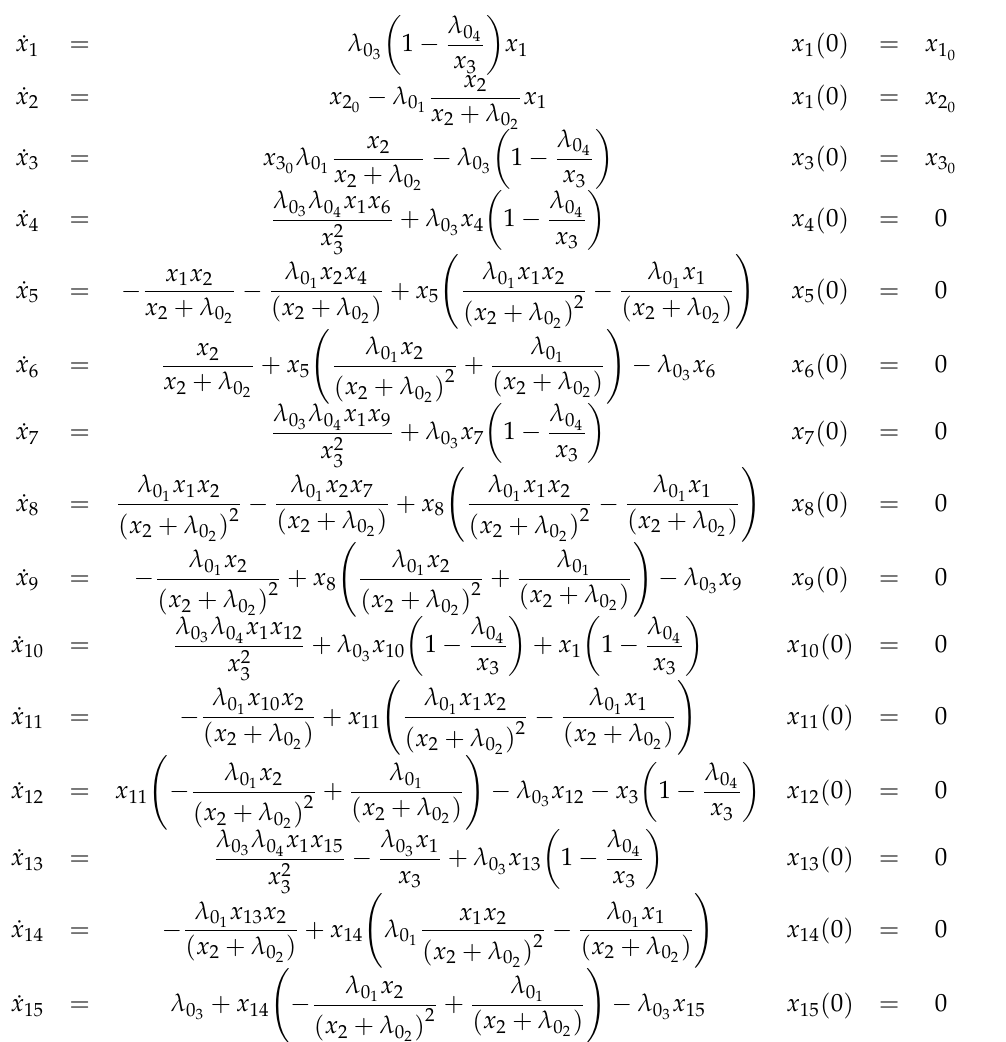
in Figure 6. The nominal parameter values λ 0 = 2 d − 1 , and λ = 0.03 mgN ( mgC ) − 1 used for the simulation were set based on λ 0 0 4 3